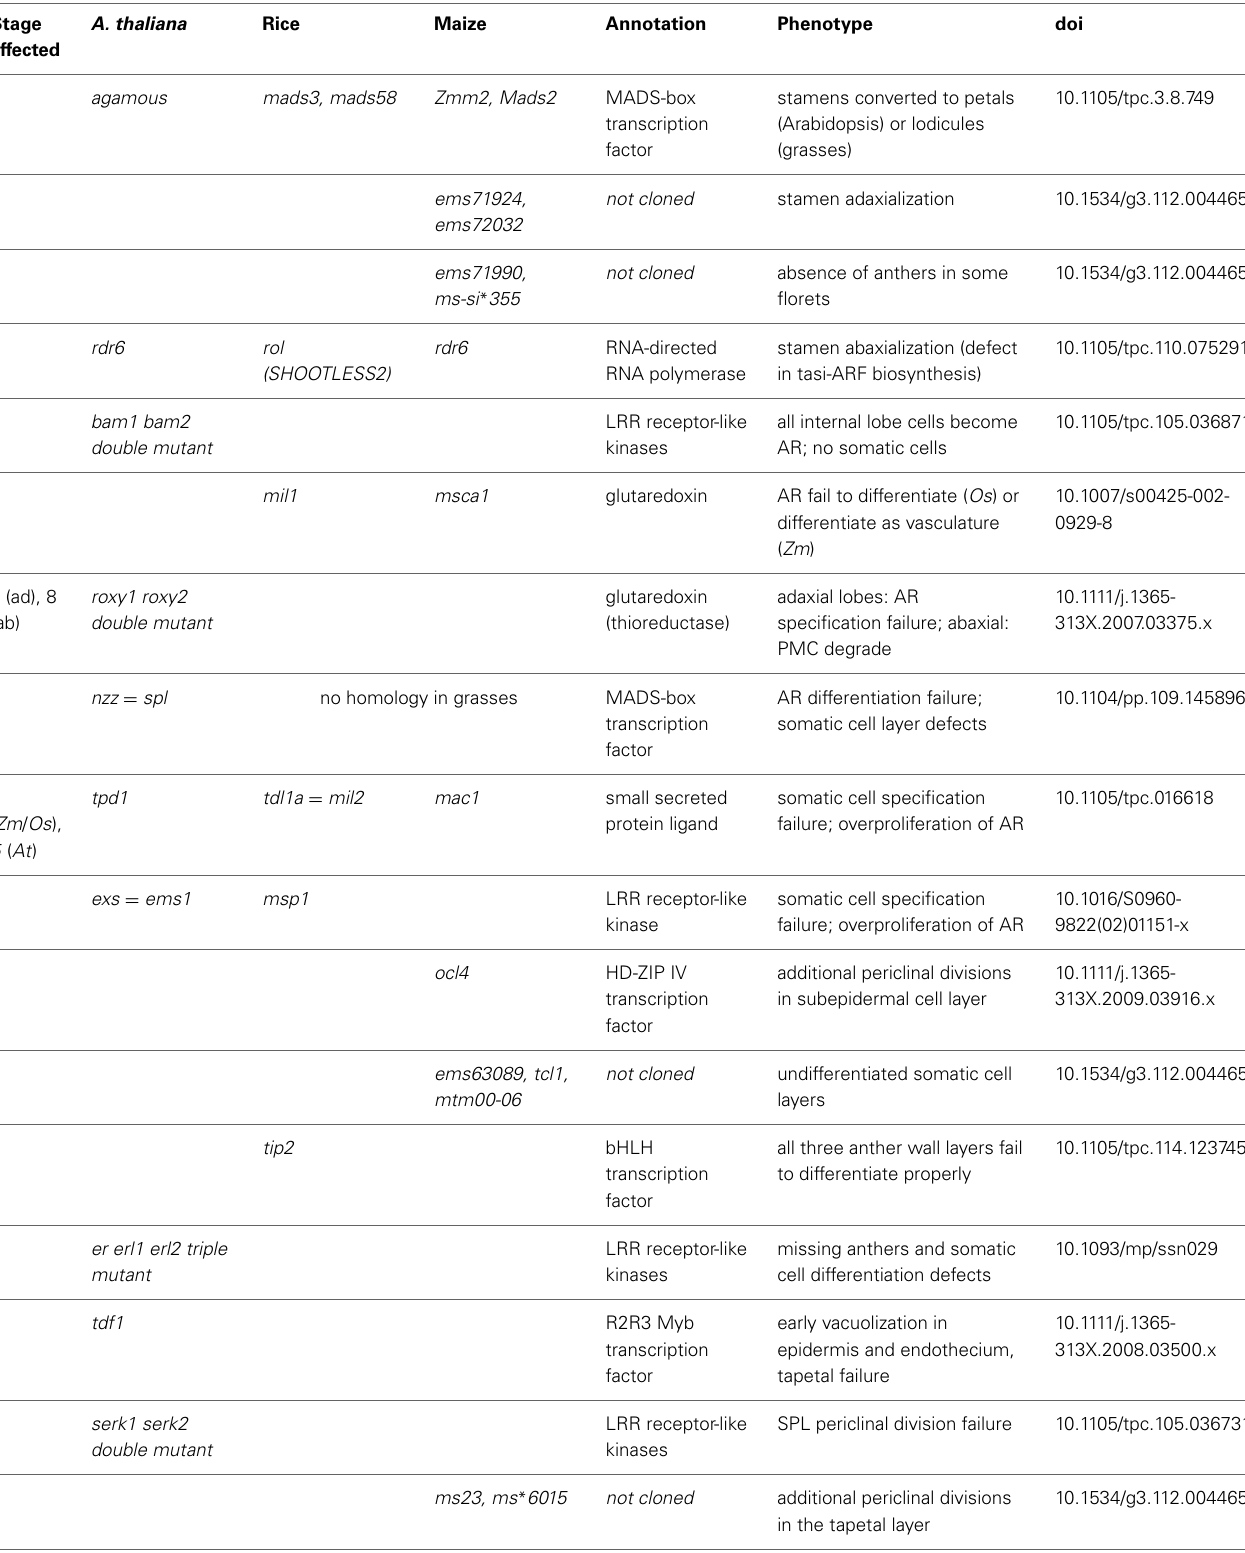
Table 1 | A comprehensive list of anther mutants sequentially organized from organ specification through meiosis.